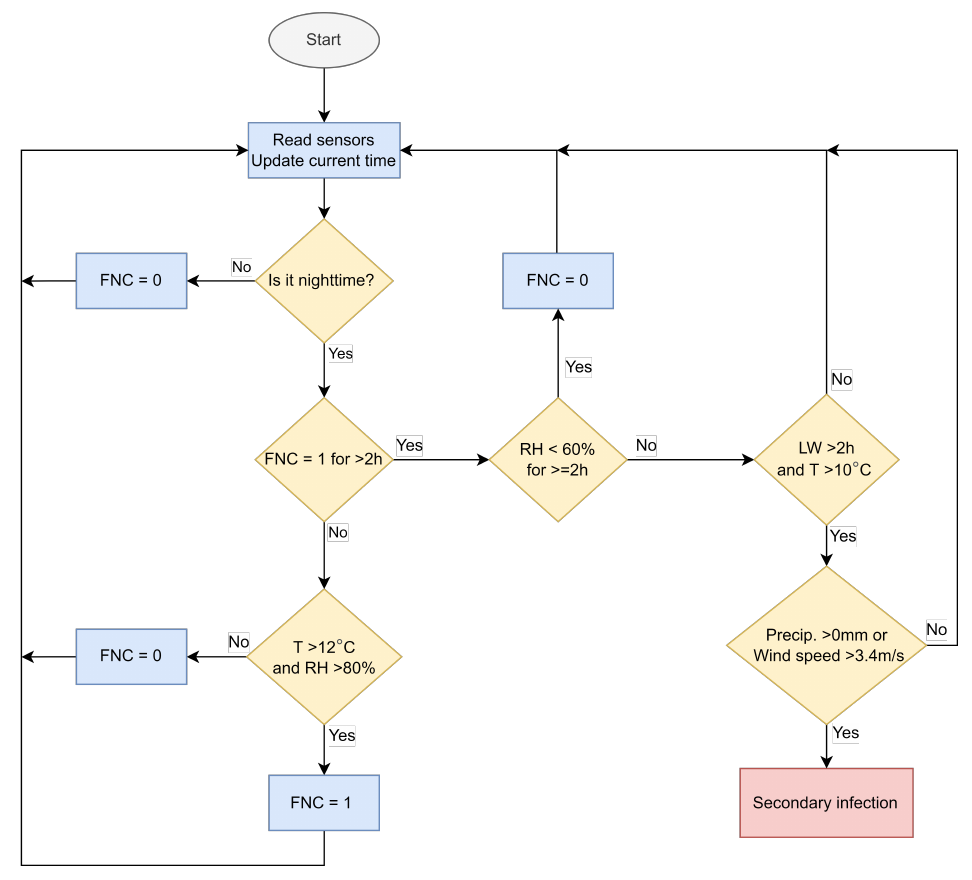
Figure 4. Algorithm for secondary infection alarms.